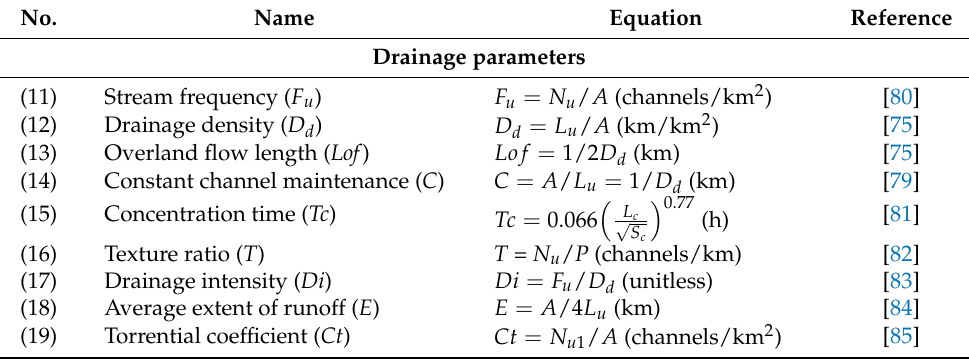
Table 2. System of methods and principles used for computation of geomorphometric parameters related to